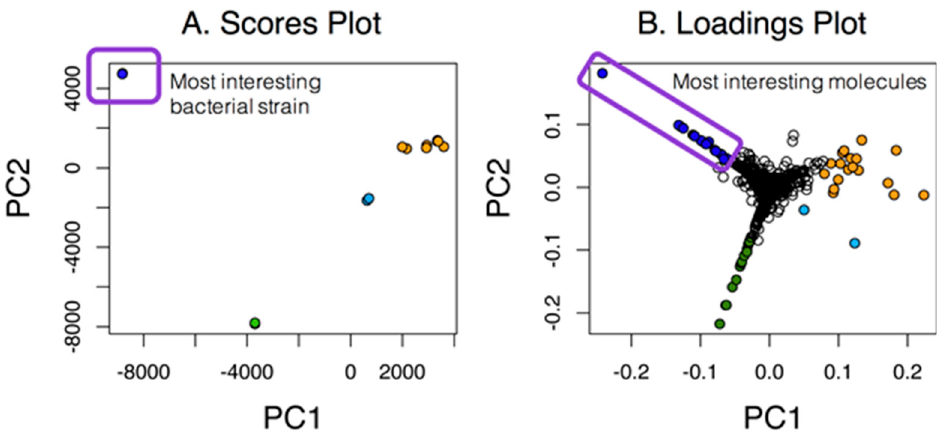
Figure 1. A PCA scores and loadings plot for seven marine actinomycetes with two replicates. For this case, the strain represented by the dark blue circles in the scores plot was the most unique, as indicated by the large separation in PC1. Molecules that were unique to that strain were color-coded in the same dark blue in the loadings plot.